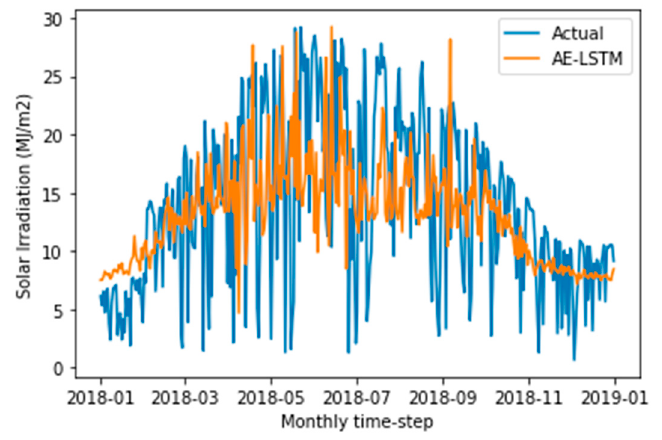
Figure 11. Comparison of 2018 daily predicted solar radiation data by AE-LSTM vs. actual values. Energies 2020 , 13 , 4373